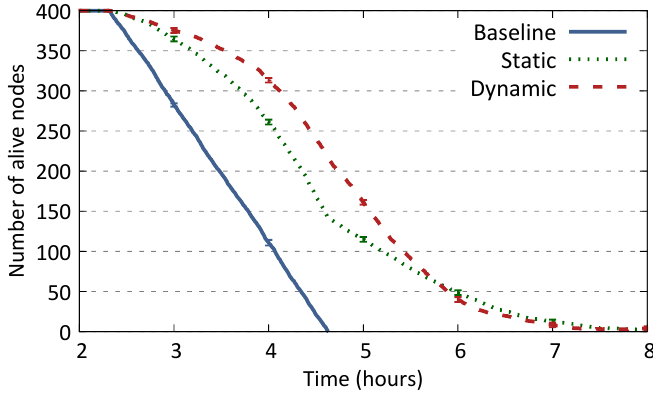
Figure 8. Number of alive nodes over